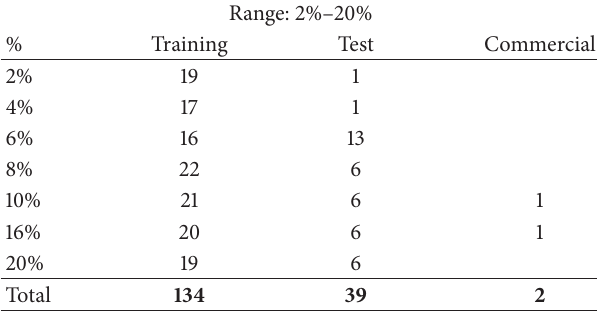
Figure 6: IR spectrum, specific to a sample. Table 2: Samples with low